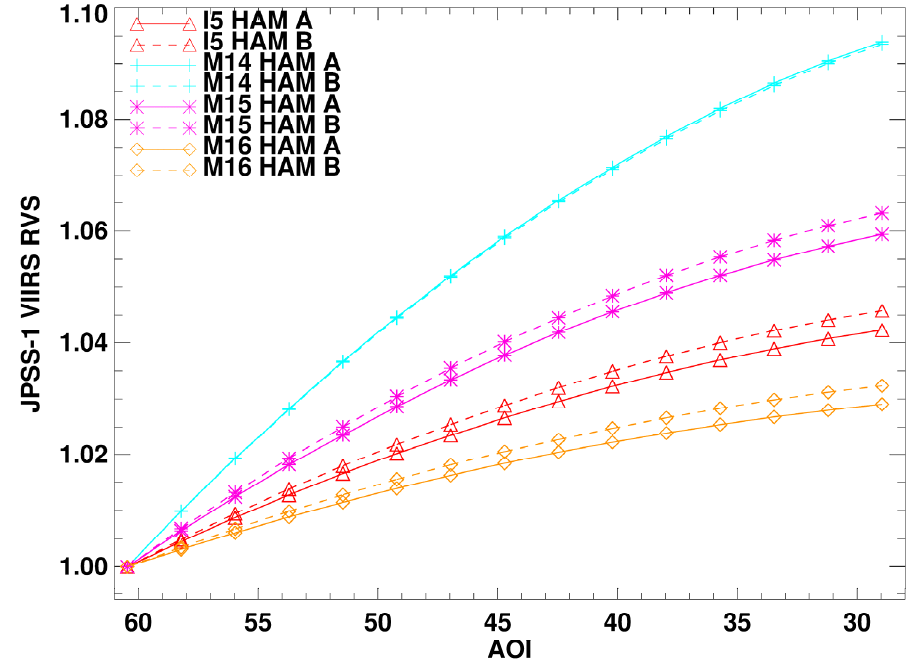
Figure 17. Band-averaged RVS for JPSS-1 VIIRS all TEBs from the SV AOI through to the end of scan AOI for the Long Wavelength Infrared (LWIR) bands.